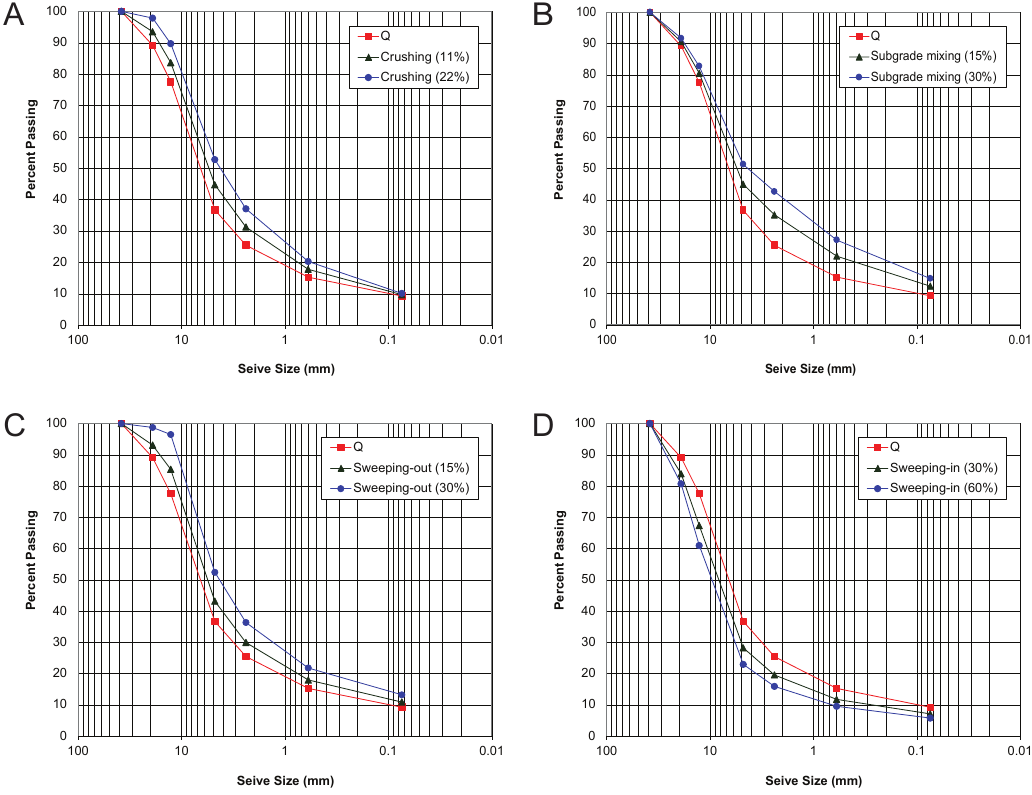
Figure 3. Initial models of how the tra ffi c-induced processes change the particle size distribution from the quarry (Q): ( A ) Crushing, ( B ) subgrade mixing, ( C ) sweeping-out, and ( D ) sweeping-in. Details on the modeled particle size distributions are shown in Tables S1–S3. A set of the models that used a half of the model parameter values are also